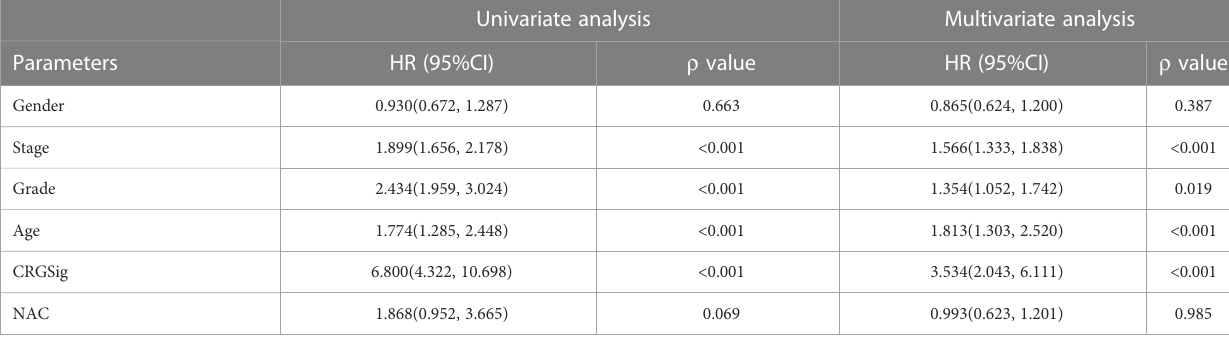
TABLE 1 Univariate and multivariate Cox analyses of clinical parameters and risk signature.